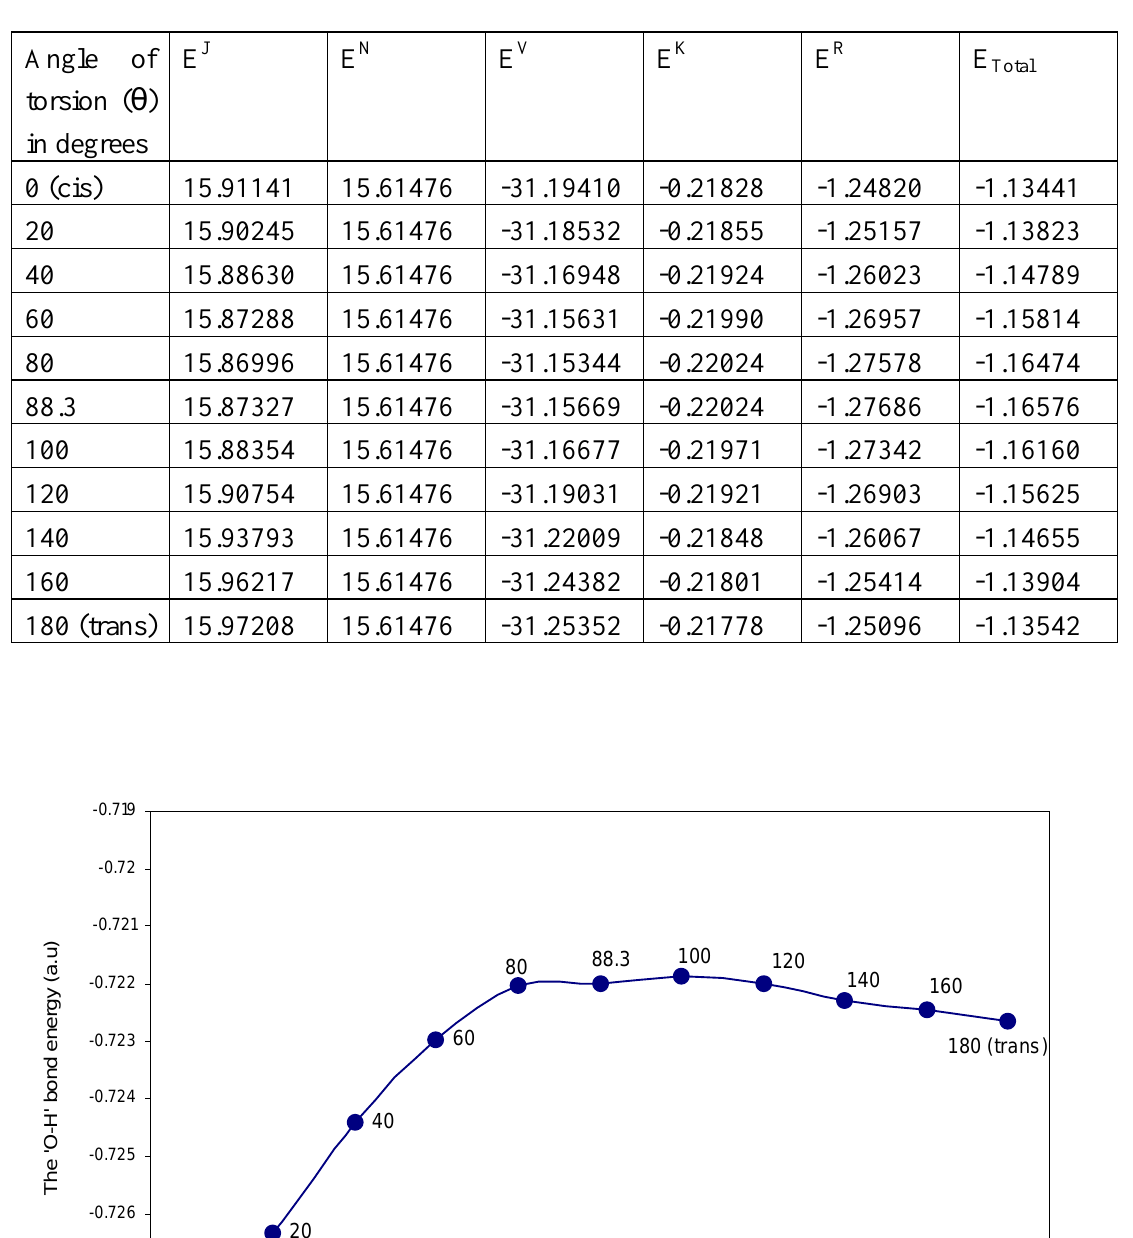
Table 3. The (O—O) bonding interactions and its decomposed components (a.u) in Hydrogen Peroxide with torsion.